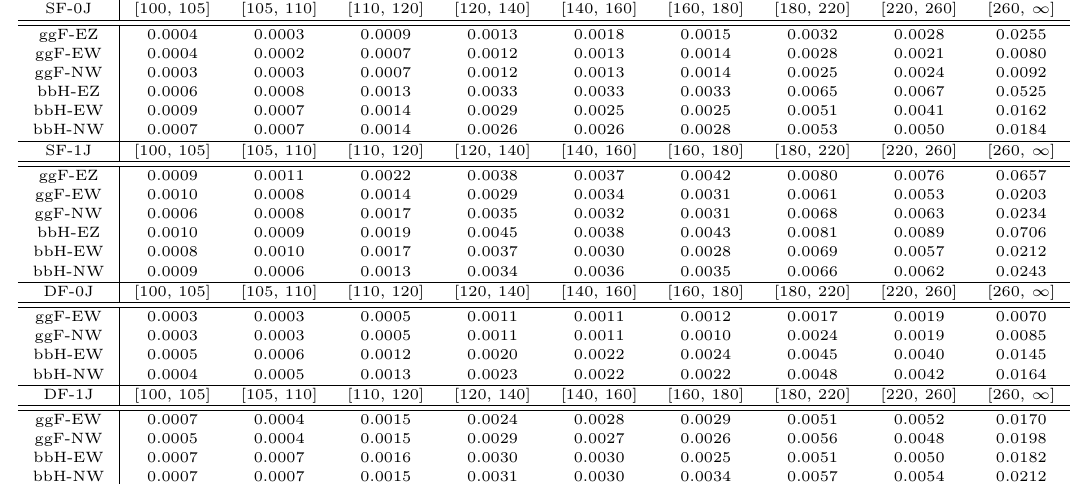
Table 3 . Efficiencies for the m T 2 bins in the SRs of the 2 ‘ + E miss processes. The masses are ( m Φ , m e